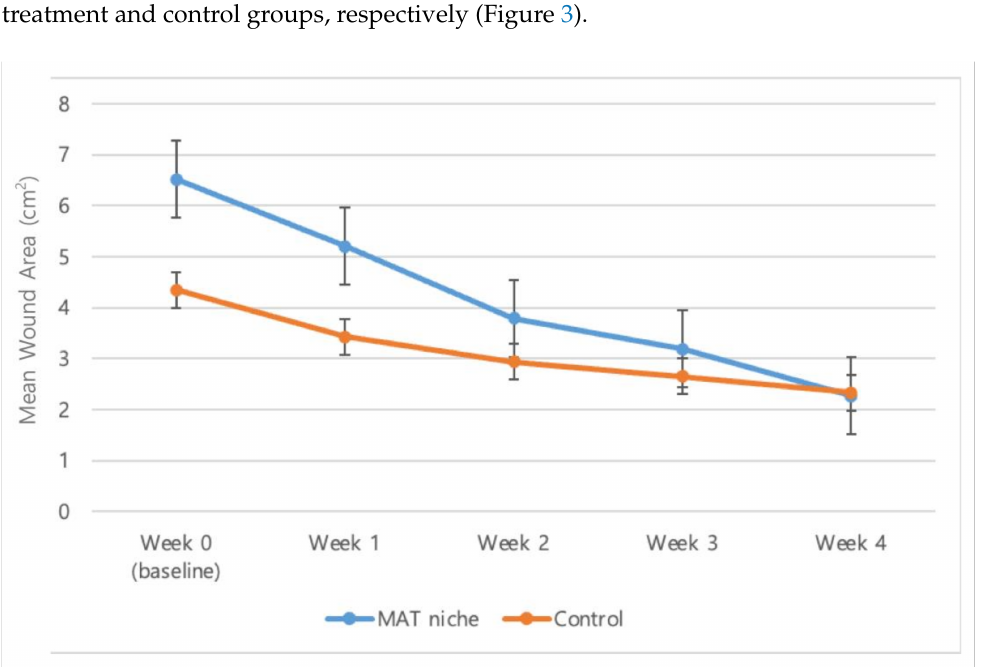
Figure 3. The mean wound area from baseline to the 4 week visit. The wound size was reduced by 4.3 ± 1.0 cm 2 (mean ± SD) and 2.0 ± 1.1 cm 2 in the treatment and control groups, respectively. The reduction rates were 77.1% ± 4.9% and 45.7% ± 15.6% in the treatment and control groups,